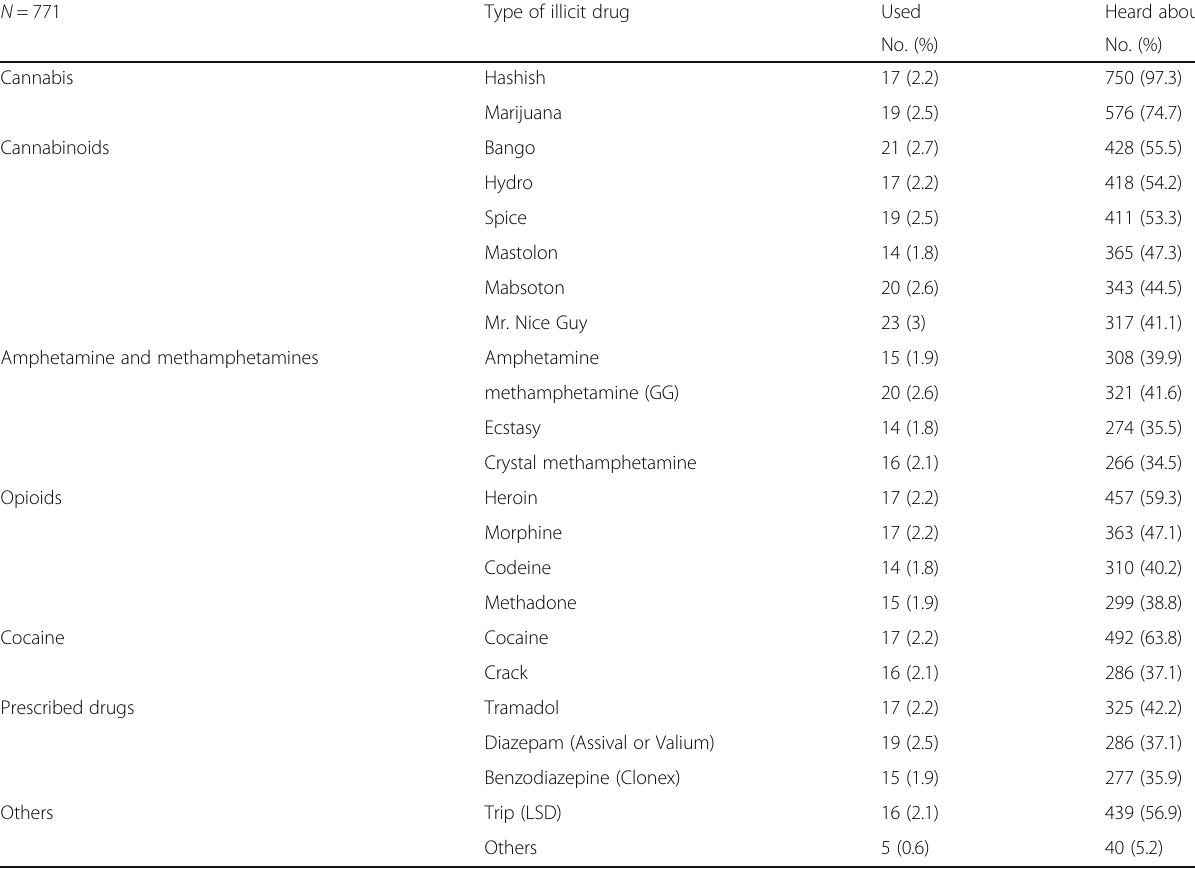
Table 3 Types of illicit drugs used by participants N = 771 Type of illicit drug Used Heard